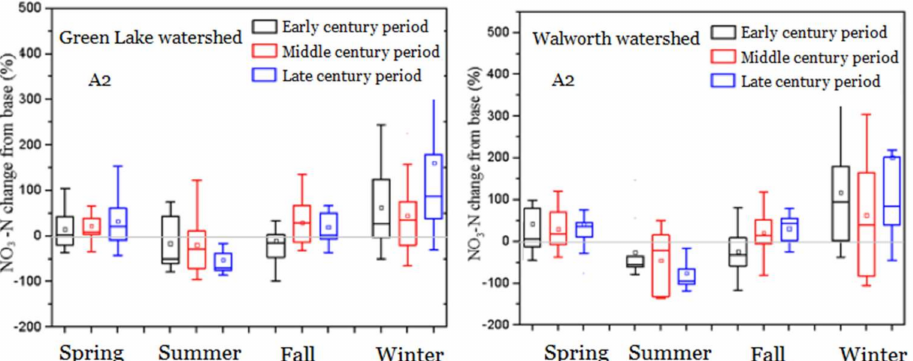
Figure 7. Seasonal changes of nitrate-nitrogen (NO 3 -N) losses of the Green Lake watershed and the Walworth watershed under A2 scenario. ( left ): Green Lake watershed, ( right ): Walworth